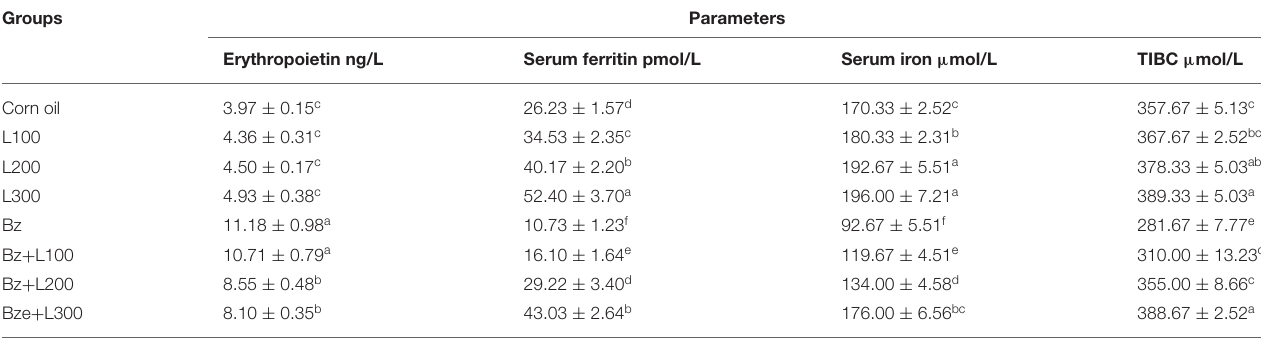
TABLE 3 | Effect of bovine lactoferrin on erythropoietin and serum iron profile in benzene-induced hematotoxicity. Groups